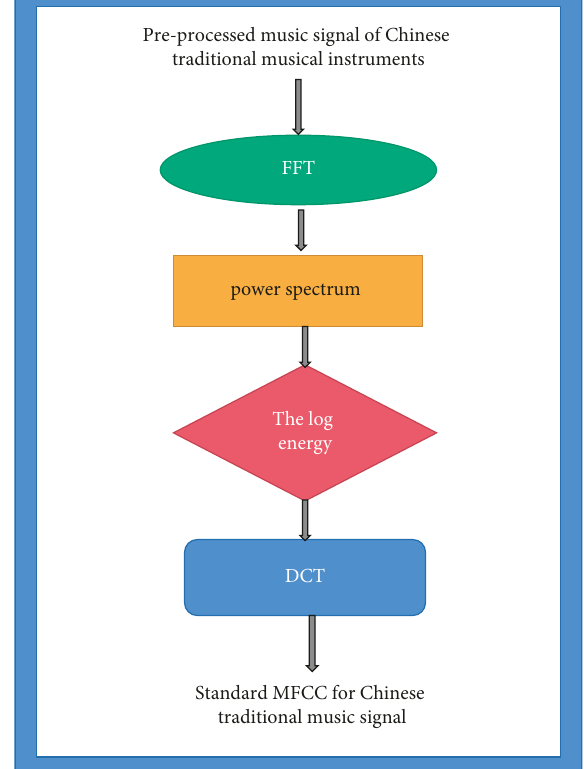
Figure 5: Flow chart of standard MFCC parameter extraction of Chinese traditional musical instrument music.